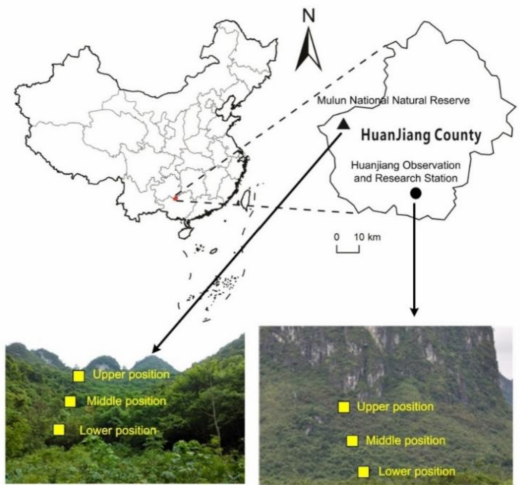
Figure 1. Map showing the Huanjiang Observation and Research Station ( • ) and Mulun National Nat- ural Reserve ( (cid:78) ) in a karst ecosystem, southwestern China, and relative slope positions for sampling. The shrubland plots were established in the Huanjiang Observation and Research Station (24 ◦ 43 (cid:48) 58.9 (cid:48)(cid:48) –24 ◦ 44 (cid:48) 48.8 (cid:48)(cid:48) N, 108 ◦ 18 (cid:48) 56.9 (cid:48)(cid:48) –108 ◦ 19 (cid:48) 58.4 (cid:48)(cid:48) E) of the Chinese Academy of Sciences, and covers an area of 146.1 ha. This area experienced severe deforestation from 1958 to the mid-1980s and has been recovering through natural revegetation from the mid- 1980s to the present day. Nowadays, approximately 70% of the hillslopes are dominated by shrubs [44]. The forest plots were established in the Mulun National Natural Reserve (25 ◦ 06 (cid:48) 09 (cid:48)(cid:48) –25 ◦ 12 (cid:48) 25 (cid:48)(cid:48) N, 107 ◦ 53 (cid:48) 29 (cid:48)(cid:48) –108 ◦ 05 (cid:48) 42 (cid:48)(cid:48) E), which is approximately 35 km